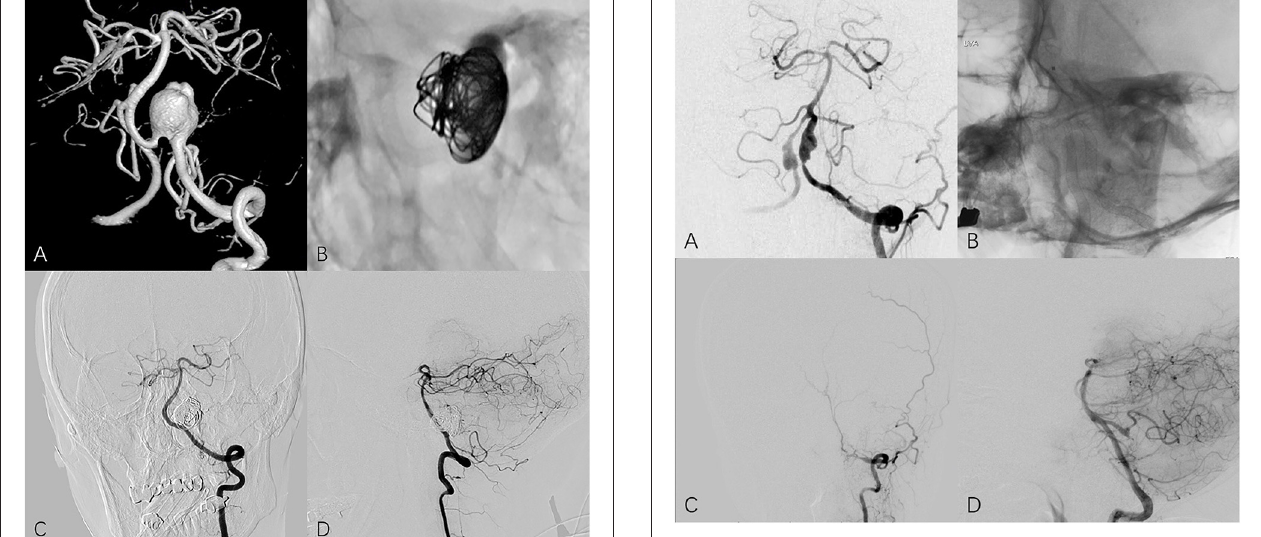
FIGURE 1 | Fifty four year-old female with left vertebral artery aneurysm. (A) A 3-dimensional reconstruction image of a vertebral angiogram shows an irregular aneurysm involving PICA. (B) Non-subtracted oblique view shows PED in place and loosely filling coils. Follow-up frontal (C) and lateral (D) angiography shows the aneurysm is completely occluded and PICA remains patency.